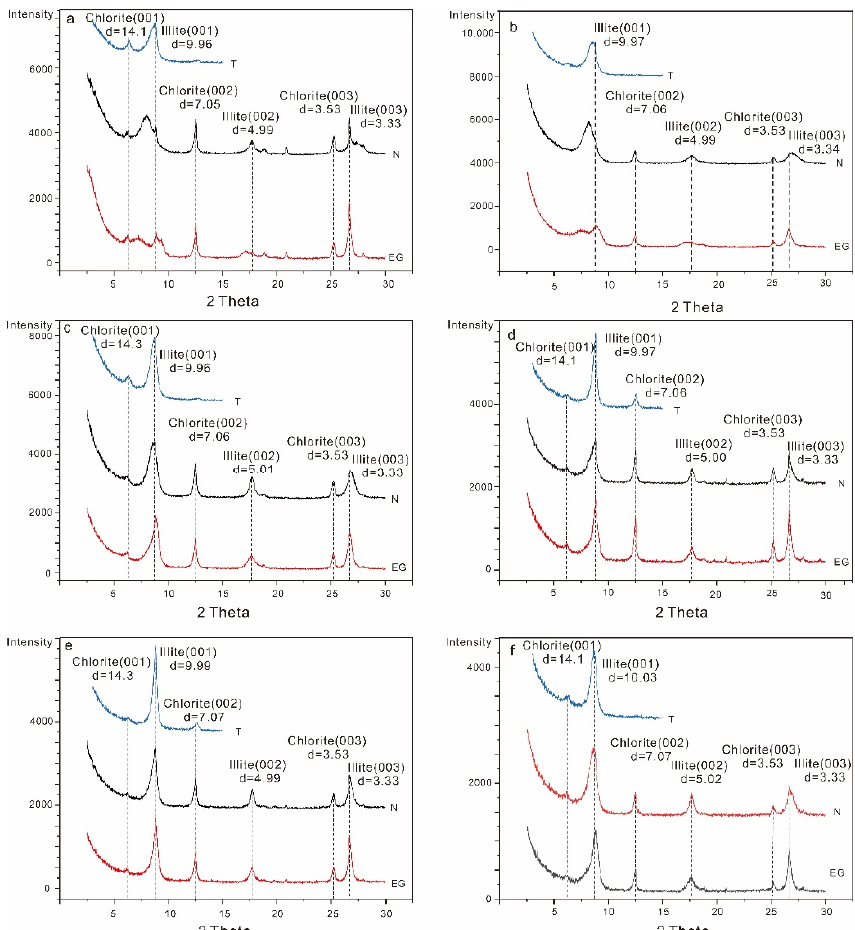
Figure 6. XRD patterns of six typical clay mineral samples at different depths from the Shahezi mineral in SK-2. ( a ) Mudstone samples at 3436 m; ( b ) mudstone samples at 3736 m; ( c ) mudstone samples at 4126 m; ( d ) mudstone samples at 4545 m; ( e ) mudstone samples at 4975 m; ( f ) mudstone samples at 5415 m. N: air ‐ dried sample; EG: ethylene glycol saturated sample; T: heated sample.